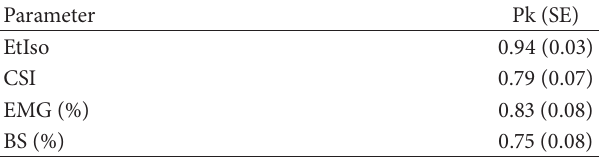
Table4:Resultsfrompredictionprobability(Pk)analysiscalculated between the clinical scale of anaesthesia (Table 3) and the different parameters studied, from pooled data of the 10 cats. The Pk value and the Jackknife standard deviation (SE) are